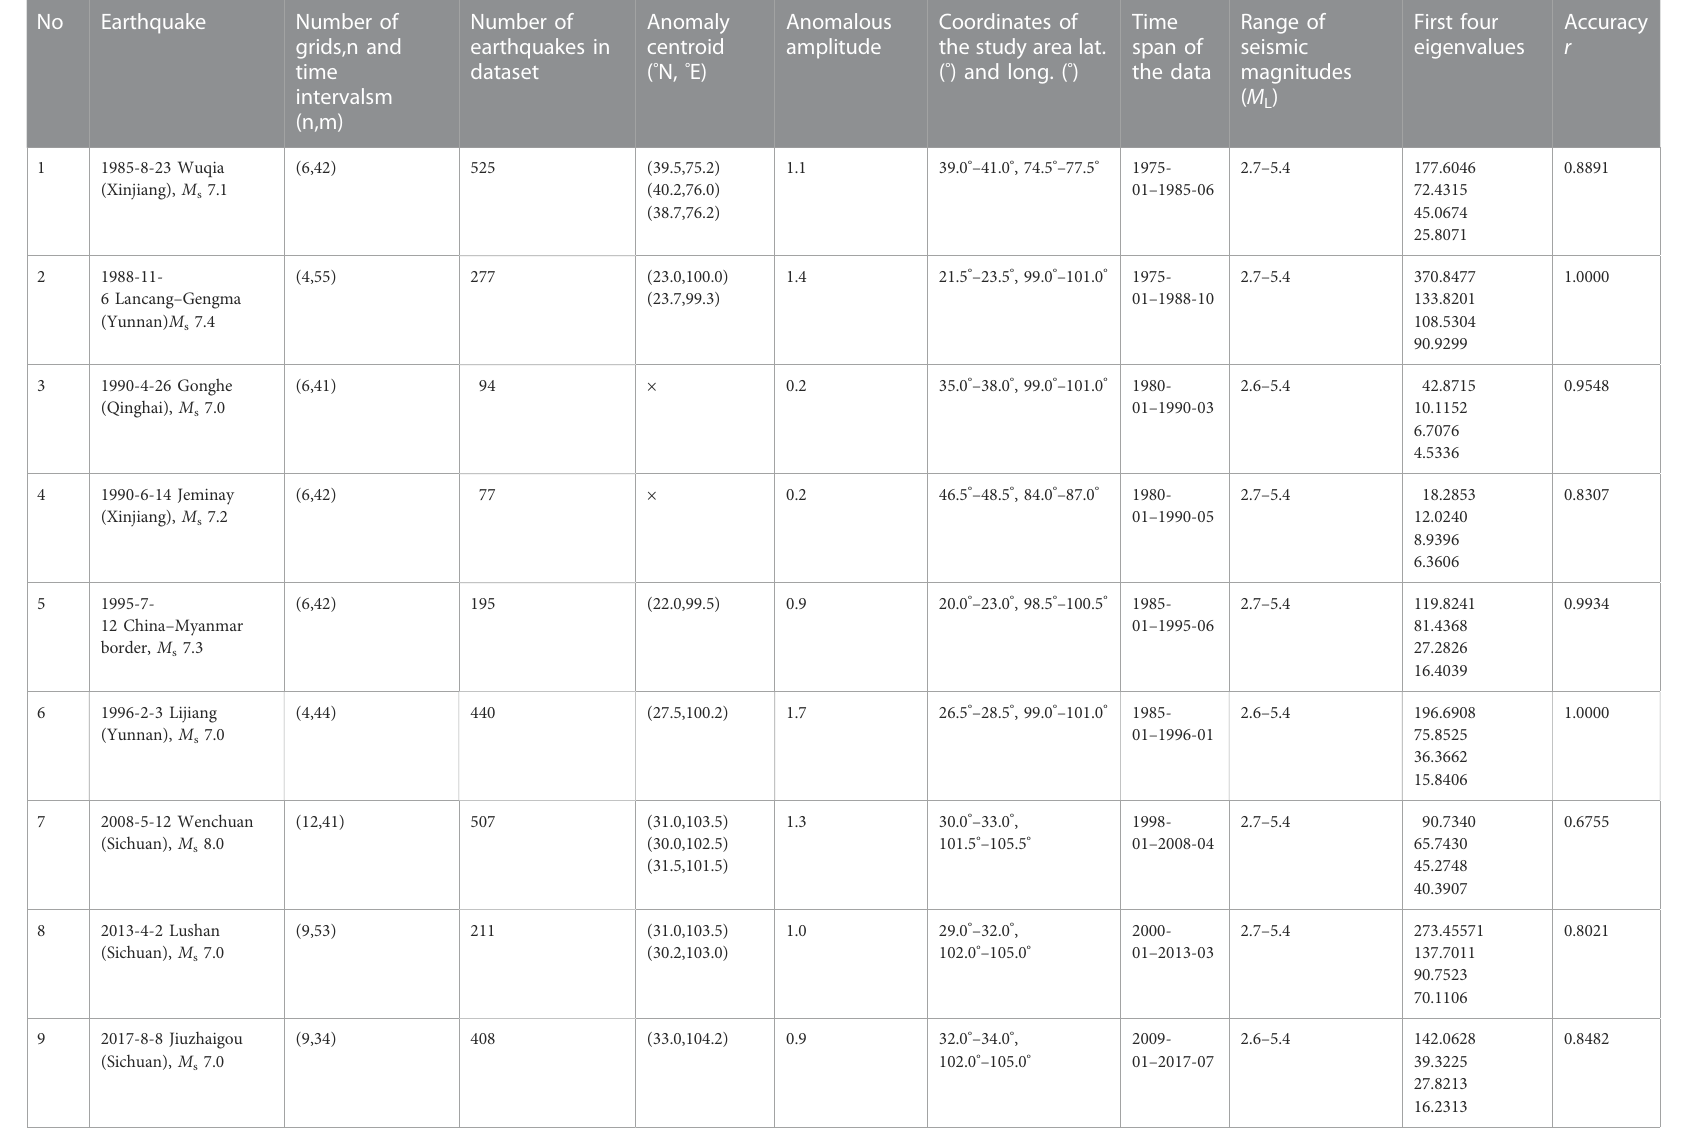
Note:TheearthquaketimeinthetableisBeijingtimeinChina.Anomalyzonesareareaswithfrequency- fi eldcontoursgreaterthan0.9(bluezones);anomalousamplitudeisthevalueofthecontourclosesttotheepicenterofthemainshock; “ × ” indicatesthat the anomalies cannot be deemed signi fi cant owing to a lack of